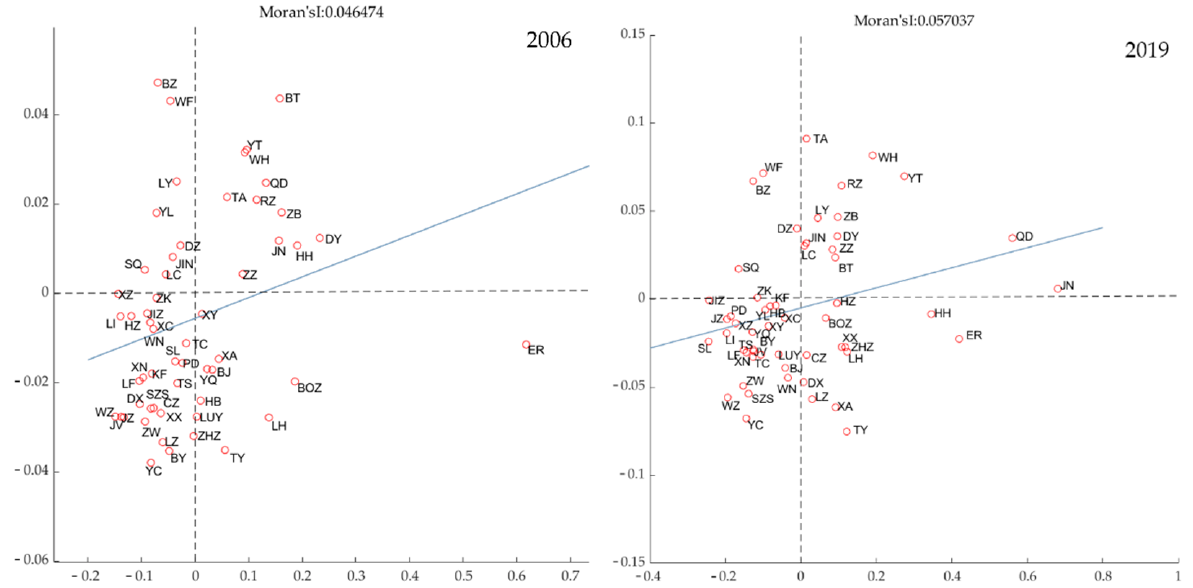
Figure 5. Local agglomeration characteristics of carbon emission efficiency in the Yellow River Basin.